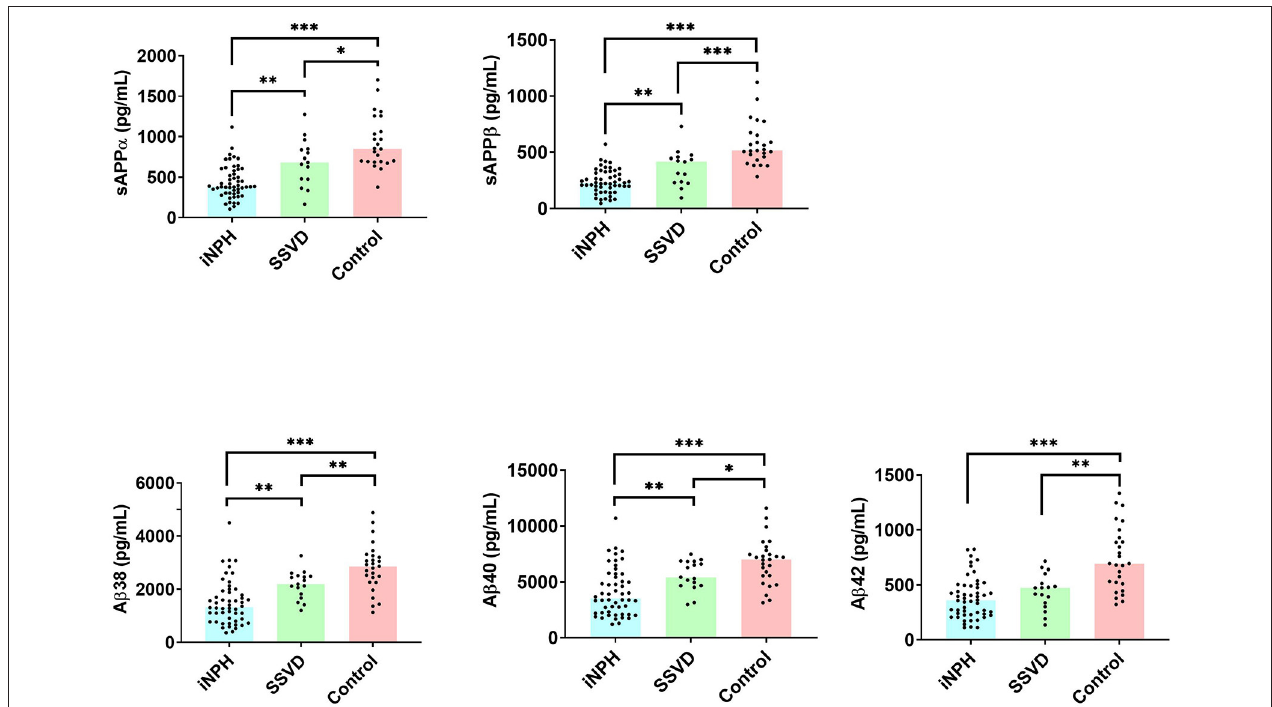
FIGURE 1 | APP-derived cerebrospinal fluid (CSF) proteins in 52 patients with idiopathic normal pressure hydrocephalus (iNPH), 17 patients with subcortical small vessel disease (SSVD), and 28 controls. Concentration is plotted as individual values. Bars indicate median values. Only significant values are marked. iNPH, idiopathic normal pressure hydrocephalus; SSVD, subcortical small vessel disease; sAPP, soluble amyloid precursor protein; A β , amyloid-beta. * p < 0.05, ** p < 0.01, *** p < 0.001.